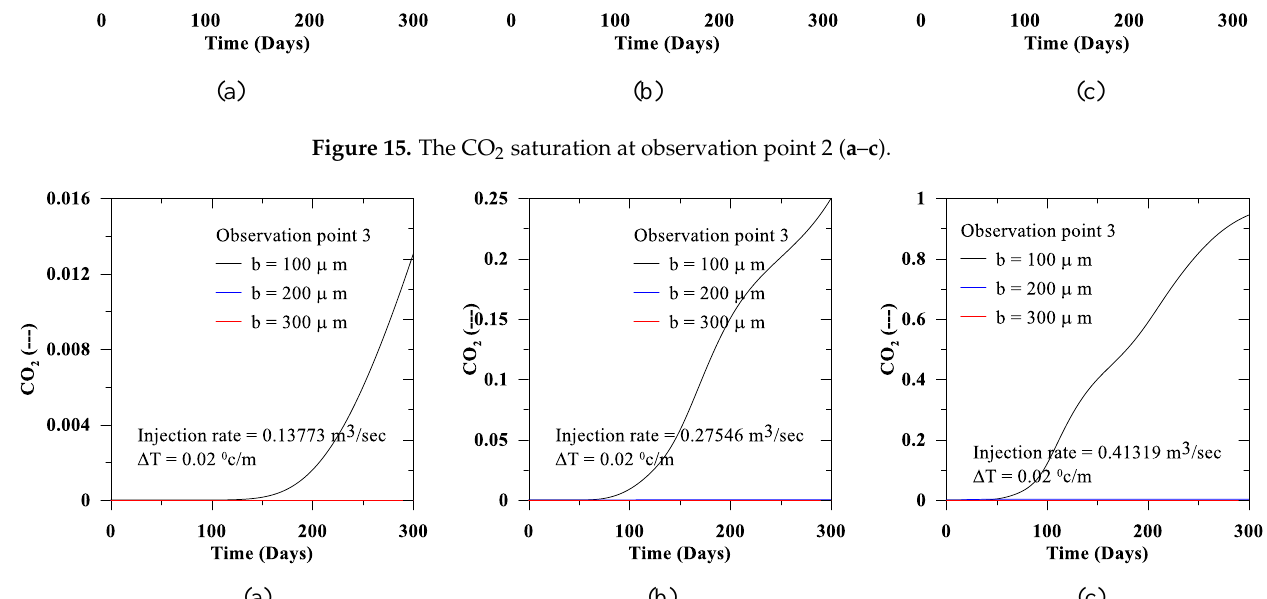
Figure 16. The CO 2 saturation at observation point 3 ( a – c ).